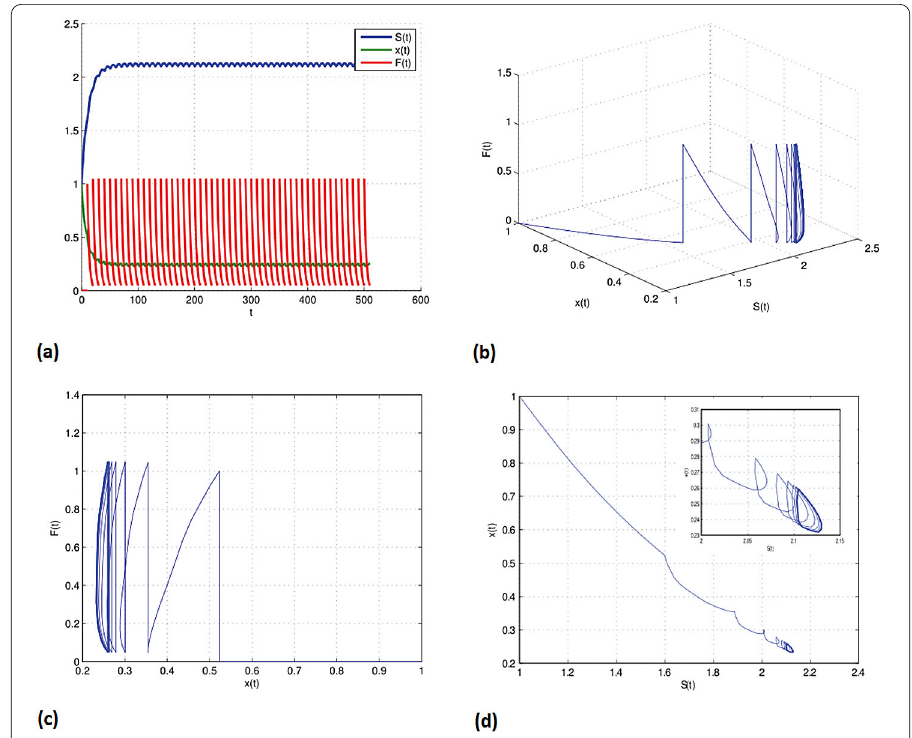
Figure 5 Dynamical behavior of solutions of system (26) with R 2 = 1.0069 > 1. (a) Time series of S ( t ), x ( t ), F ( t ). (b) Three-dimensional phase diagrams of S ( t ), x ( t ), F ( t ). (c) Phase diagrams of x ( t ), F ( t ). (d) Phase diagrams of x ( t ), S ( t